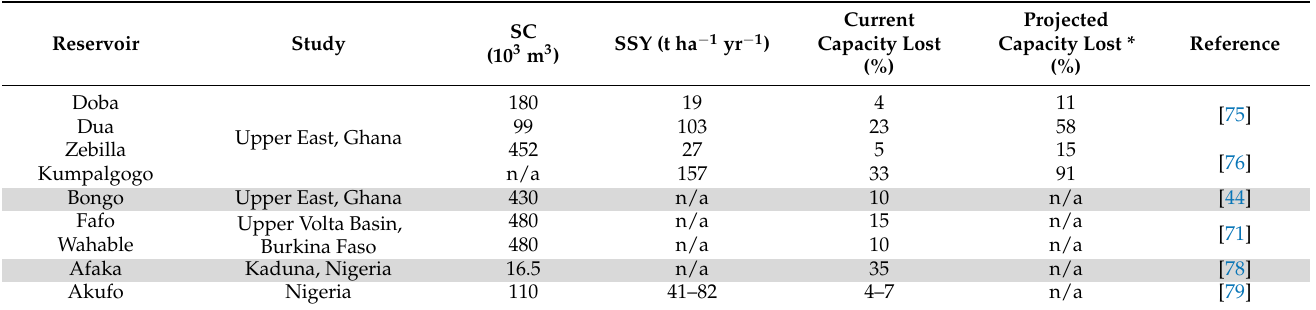
Table 9. Sediment deposition and storage capacity loss of reservoirs in West Africa.